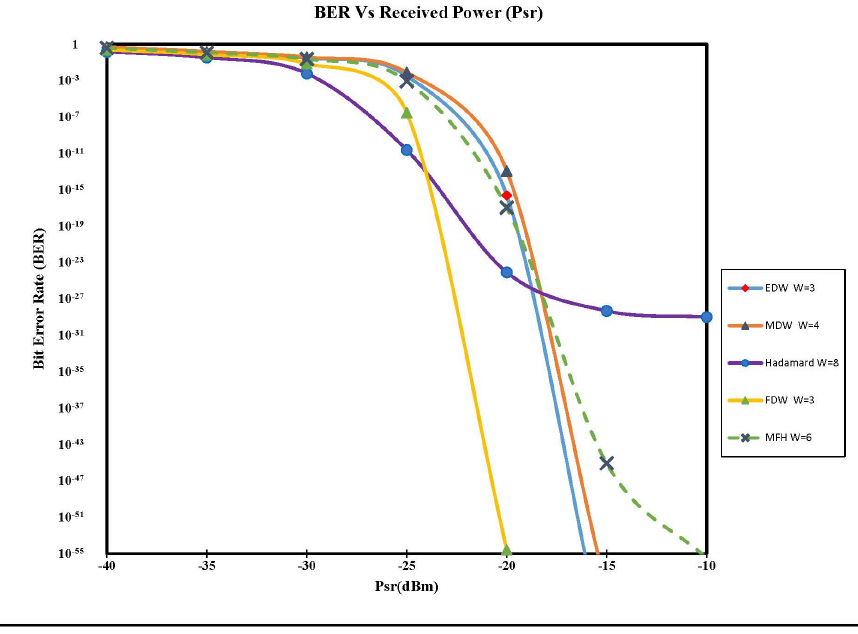
Figure 3. Performance of OCDMA code BER versus received power, Psr (dBm). Table 8. Comparison of OCDMA code based on code length and